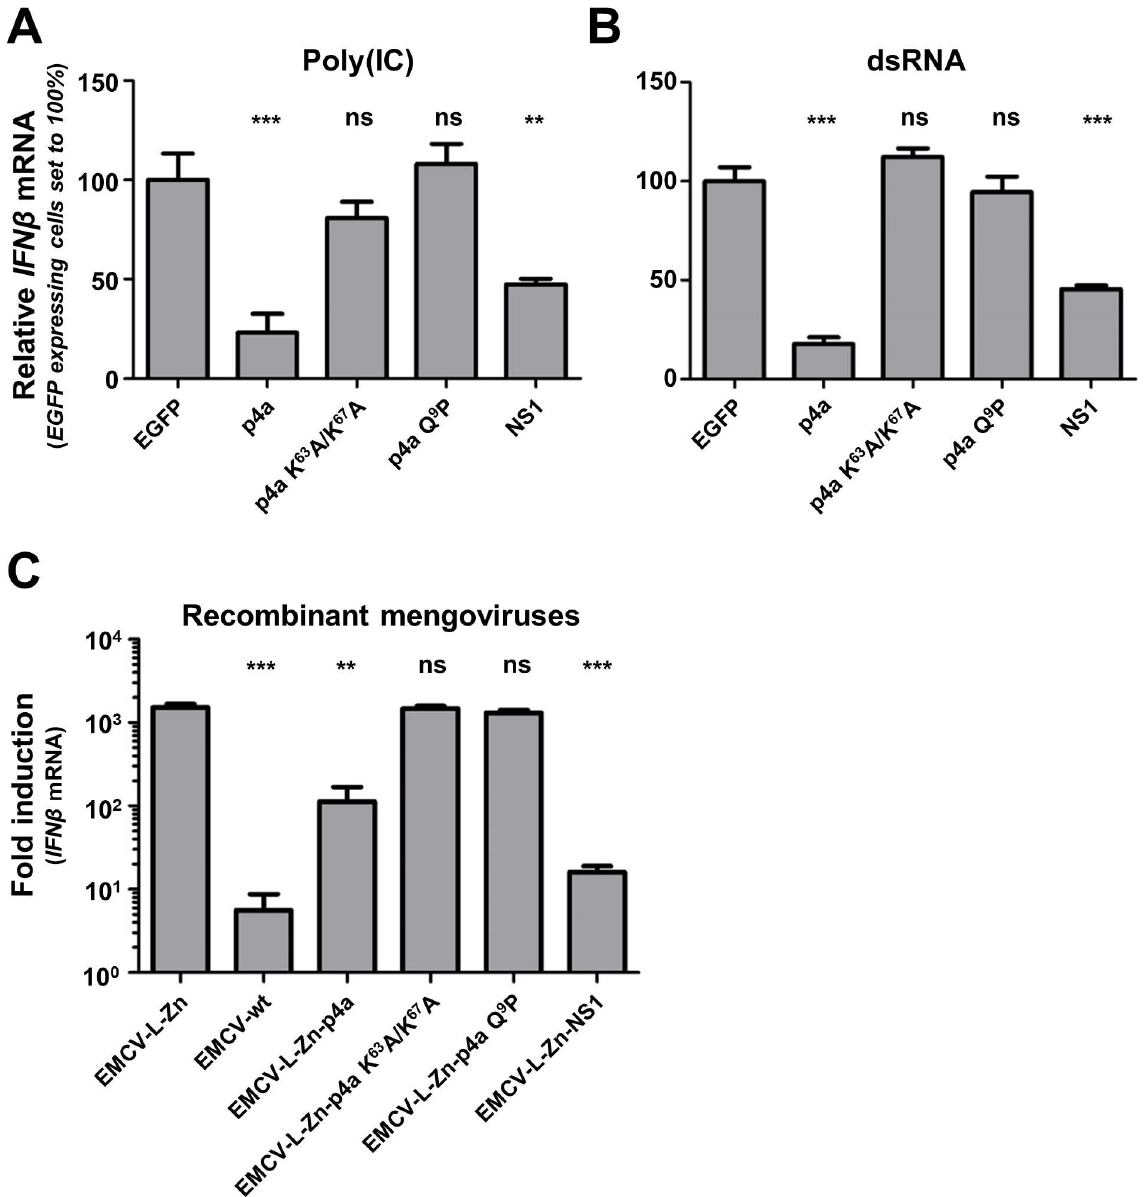
Fig 7. MERS-CoV p4a is a type I IFN antagonist. (A, B) Relative IFN β mRNA levels induced by transfection of poly(I:C) (A) or 6.5 kb viral dsRNA (sequence derived from the Coxsackievirus B3 genome) (B) in HeLa-wt cells expressing EGFP or EGFP-p4a fusion proteins. To obtain a cell pool in which all cells express the protein of interest, plasmidsencodingEGFP fusion proteins were co-transfected with a plasmid conferring puromycin resistance. Subsequent puromycin selection for two days eliminated non- transfected cells. RT-qPCR was used to quantify relative IFN β mRNA levels 8h post RNA ligand transfection. Shown are means and standard deviationsof the relative IFN β mRNA levels compared to EGFP-expressing cells. Analysis was performed by unpairedt-test ( *** , p < 0.001; ** , p < 0.01; ns, not significant). (C) Bar-graph showing IFN β mRNA levels induced by recombinant mengovirusinfection (MOI = 10) of HeLa cells. RT-qPCR was used to quantify relative IFN β mRNA levels at 8h post infection. Means and standard deviationsof the relative IFN β mRNA levels of triplicates are shown and analyzedusing an unpairedt-test ( *** , p < 0.001; ** , p < 0.01; ns, not